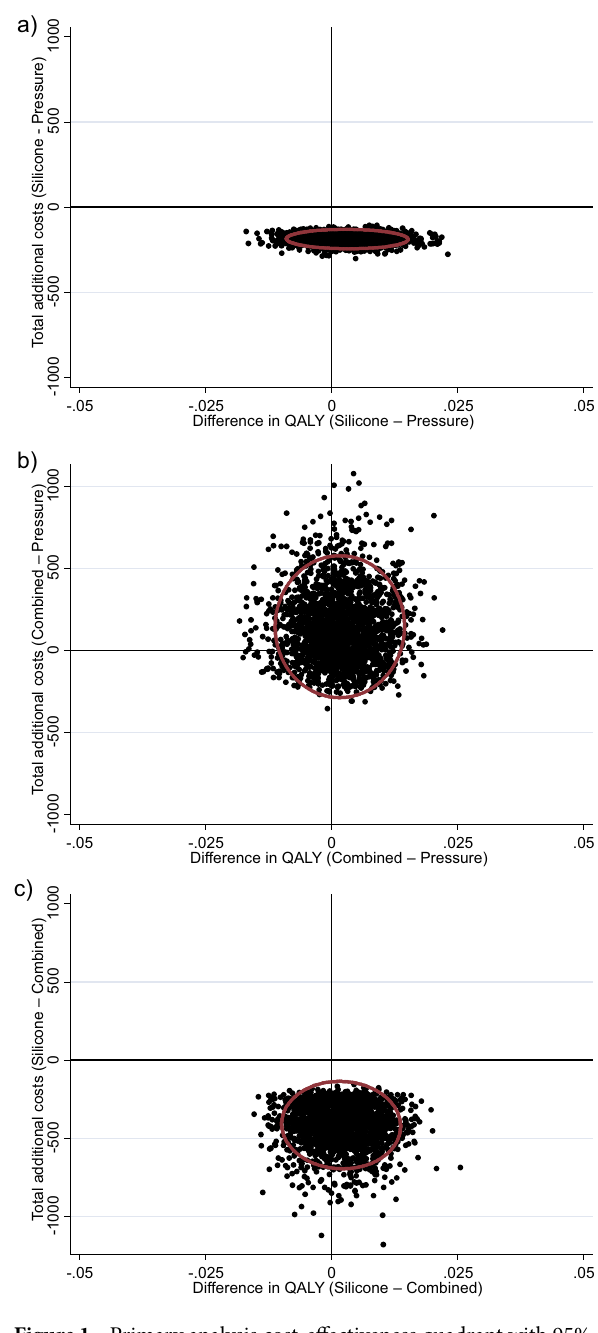
Figure 1. Primary analysis cost-effectiveness quadrant with 95% confidence ellipse (from bootstrap resampling) for cost (in Australian dollars) per additional Quality Adjusted Life Year (QALY) gained for: ( a ) Pressure garment therapy versus Topical silicone gel (less cost); ( b ) Combined versus Pressure garment therapy and ( c ) Combined versus Topical silicone gel (less